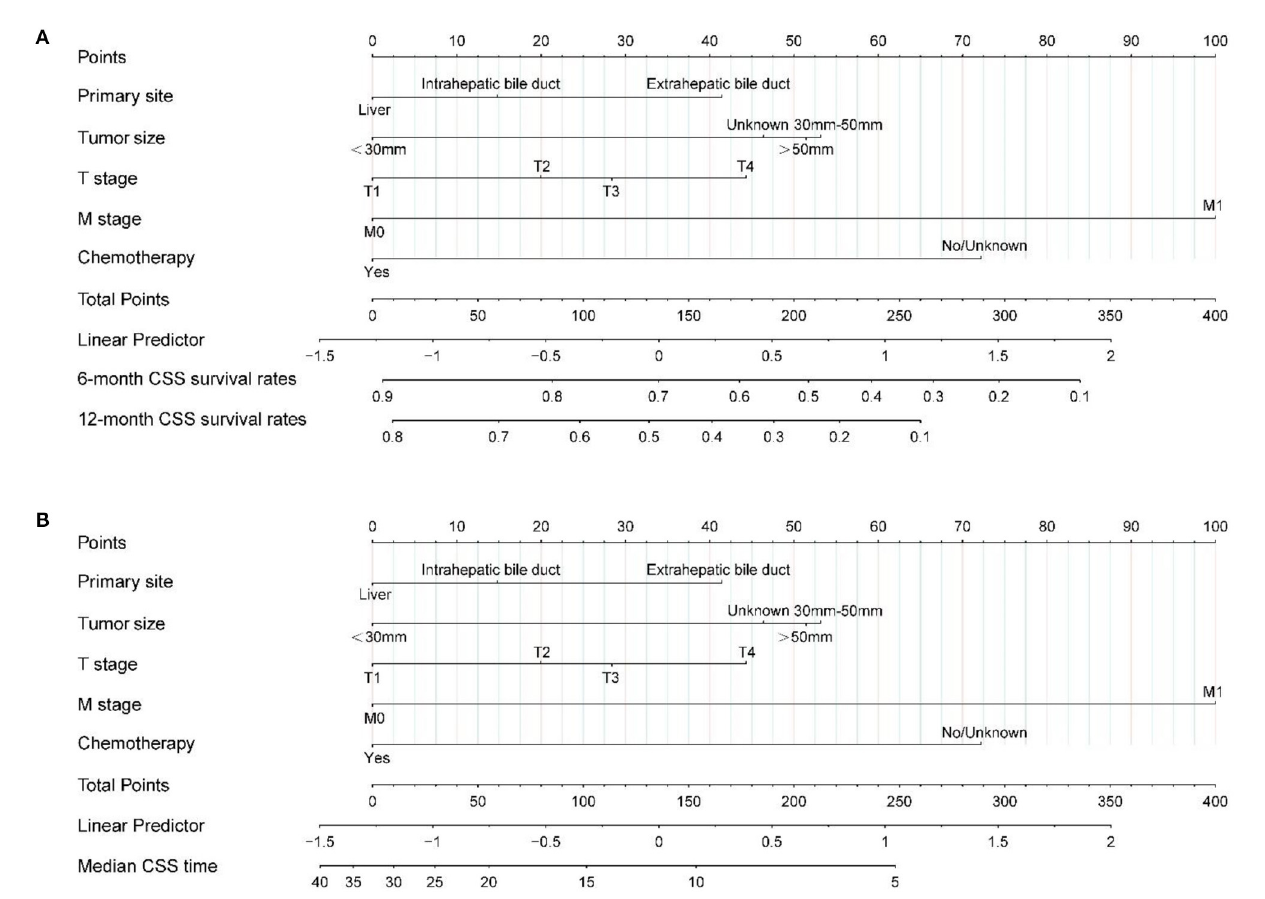
FIGURE3 Nomogram (A, B) predicting 6-, 12-month, and median CSS of patients with radiotherapy in unresected cholangiocarcinoma based on 5 prognostic factors. CSS, cancer-specific